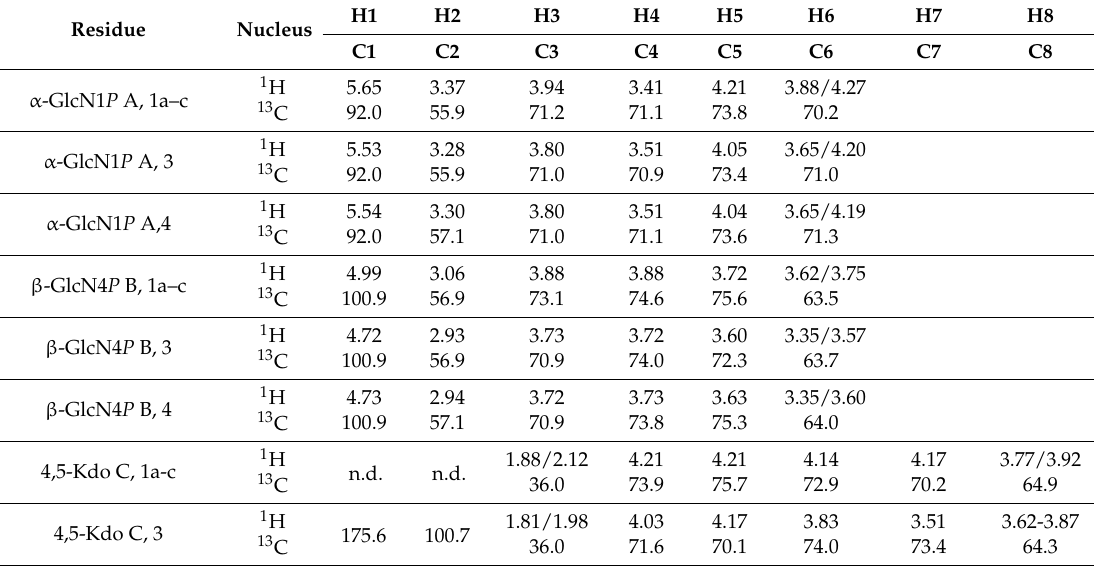
Figure 2. Anomeric ( a ) and carbinolic ( b ) region of 1 H- 13 C HSQC-DEPT of the totally deacylated LPS (L-OS KOH ) from E. amylowora waaL mutant. All the correlation cross-peaks in the anomeric region indicate the signals of structures 1a – c . The spectrum was recorded in D 2 O at 298 K at 600 MHz. Table 2. 1 H and 13 C chemical shifts ( δ ) of sugar residues of core oligosaccharides from Erwinia amylovora LPS. Nuclear Magnetic Resonance (NMR) spectra were recorded in D 2 O at 600 MHz at 298 K.